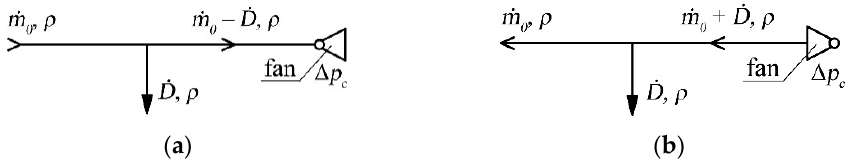
Figure 4. Gas flow chart for Case 2 under consideration: ( a ) fan working in the suction mode, ( b ) fan working in the blowing mode.